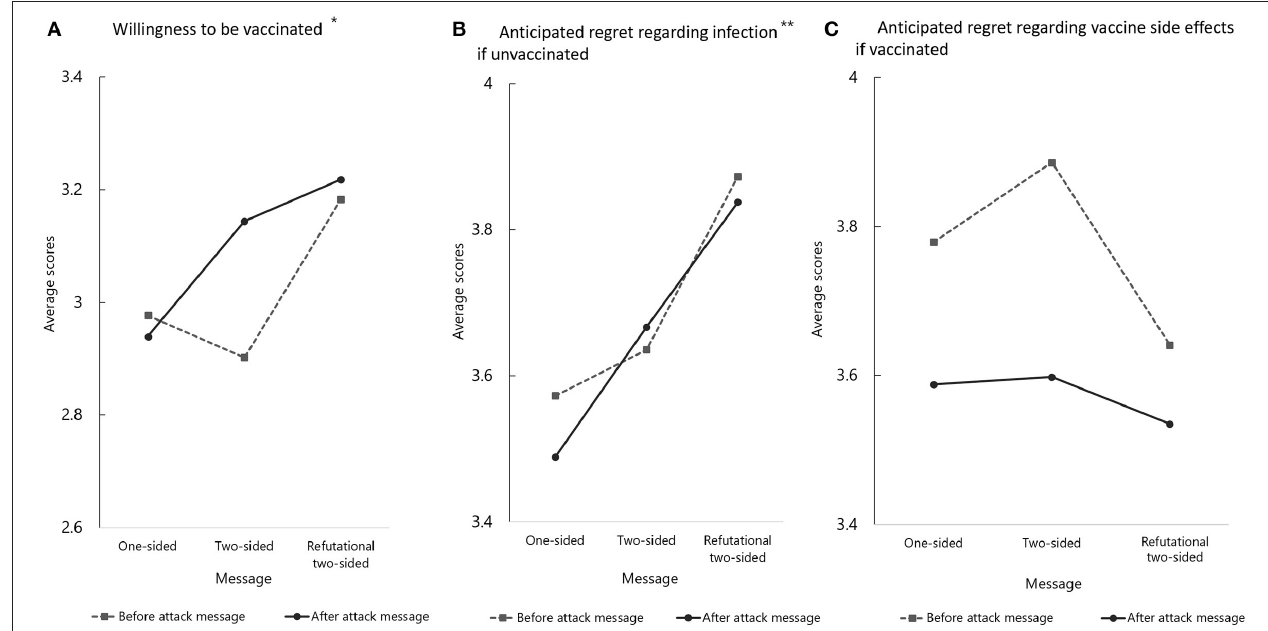
FIGURE 2 | Evaluation of vaccination intention and anxiety regarding vaccine side effects between before and after the attack message in the fictitious infectious-disease scenario. *A significant interaction between the impact of the attack message and the message groups was obtained ( p < 0.01). **Pairwise comparisons using Bonferroni correction revealed a significant difference between the one-sided and refutational two-sided message groups ( p =